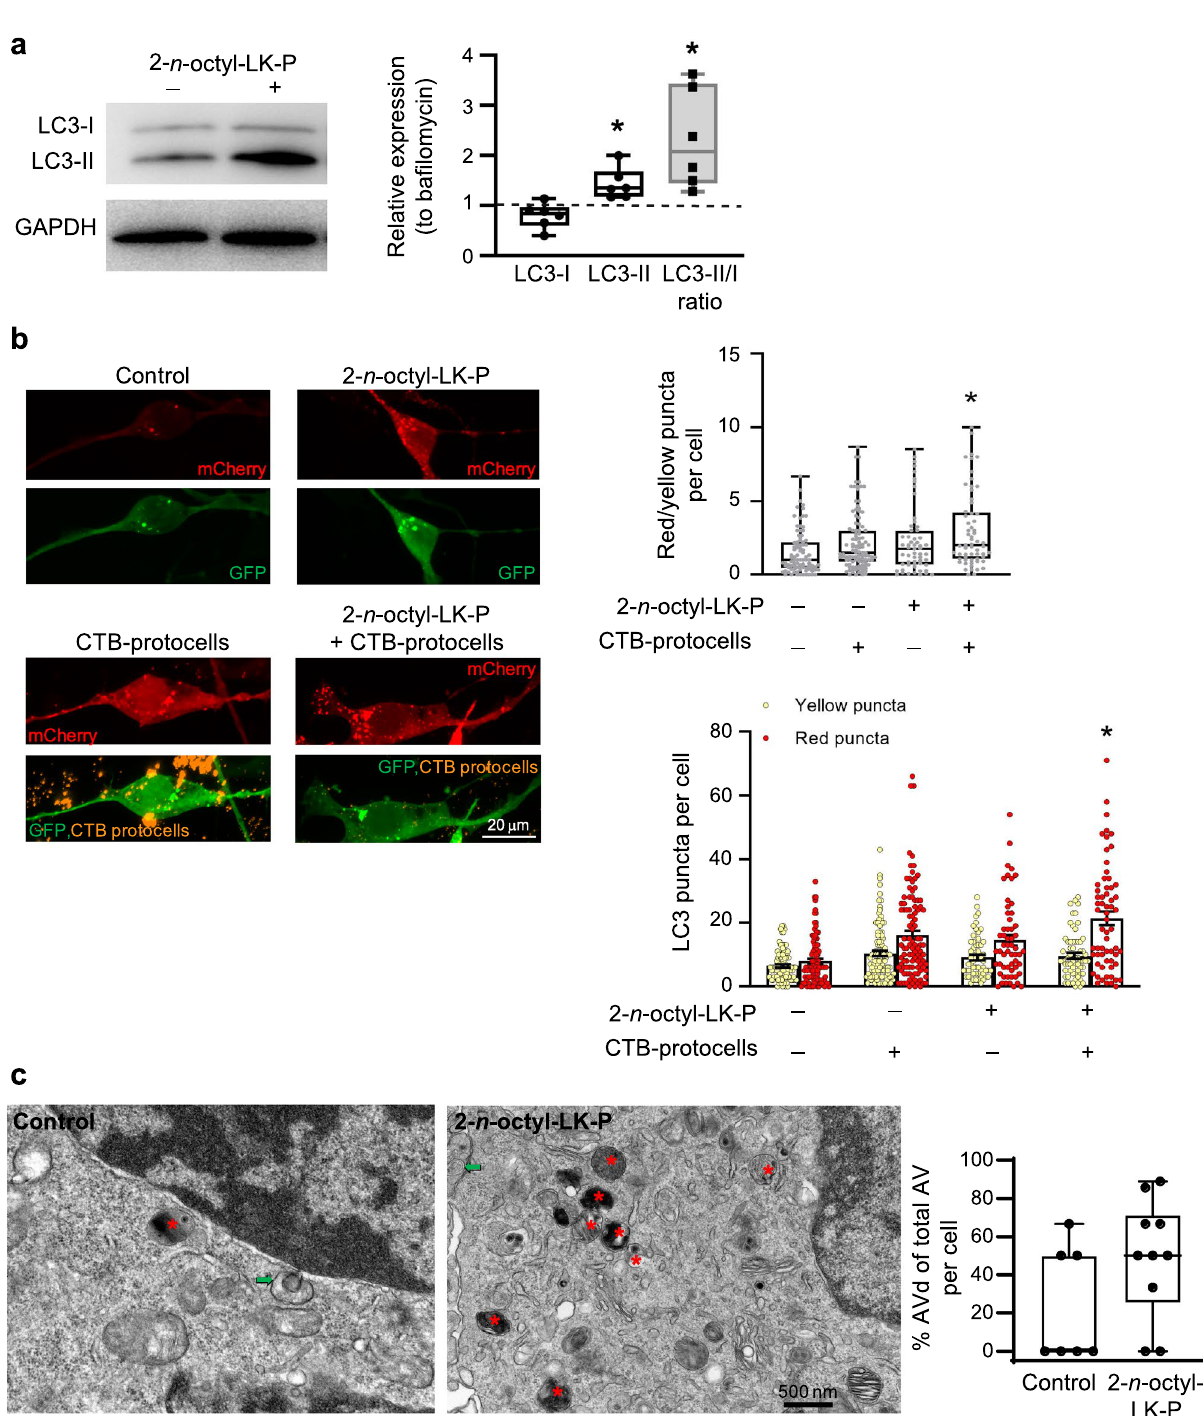
Figure 3. Autophagy flux in motor neurons after treatment with 2- n -octyl-LK-P. ( a ) Western blot analysis of LC3 protein expression in motor neurons after treatment with 2- n -octyl-LK-P in the presence of bafilomycin. Original uncropped blots are presented in Supplementary Fig. S3. Data are presented as a box plot, with the box extending from the 25th to 75th percentiles, the middle of the box at the median, and the whiskers at the minimum and maximum values. Each point represents protein expression from NSC-34 cells from a well of a 6-well plate. *, significantly different than bafilomycin treatment (p < 0.05); ( b ) Representative images of cells transfected with mCherry-GFP-LC3 plasmid followed by treatment with 2- n -octyl-LK-P or CTB-protocells containing 2- n -octyl-LK-P. n = 4 biological samples with a minimum of 20 cells per sample. Each point in the box plot/bar graph represents a single cell. *, significantly different than control treatment (p < 0.05); ( c ) Transmission electron microscopy images of NSC-34 cells with or without 2- n -octyl-LK-P treatment showing initial autophagic vacuoles (marked as green arrows) and degradative autophagic vacuole (AVd, marked as red asterisk). n = 10 cells per group from 2 biological samples. Each point in the box plot represents a single